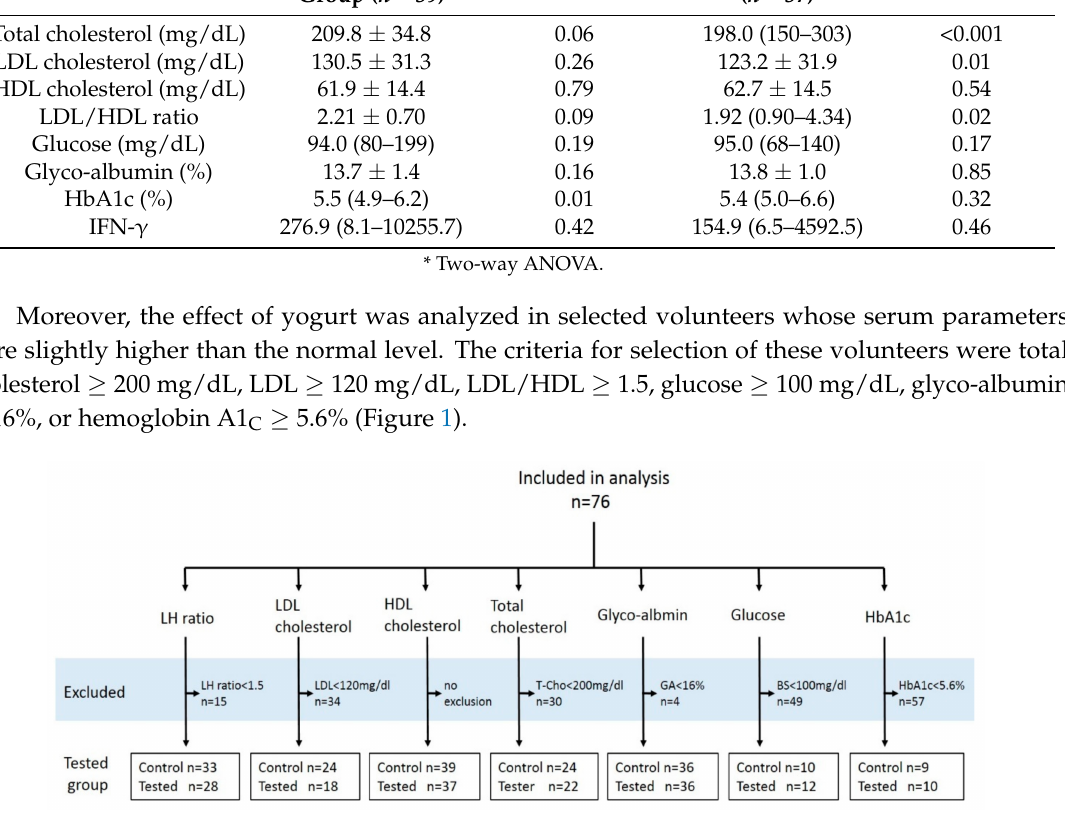
Figure 1. Summary of the subjects. The exclusion criteria are summarized in the gray highlighted section.